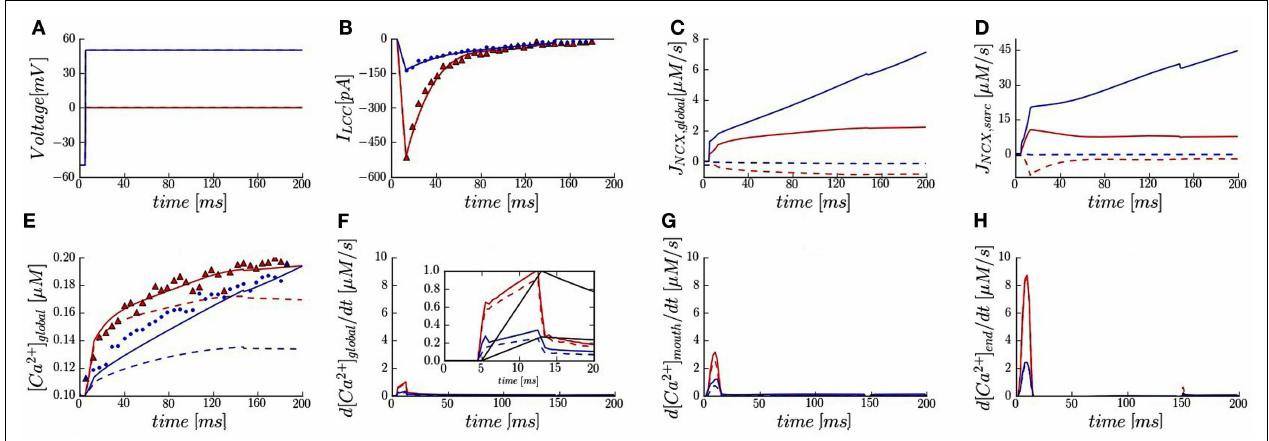
FIGURE 2 | Membrane currents, calcium signals, and trigger fluxes in the presence of 50 µ M Fluo-3. (A) Voltage-clamp protocols. (B) Whole-cell LCC current fitted and plotted ( solid lines ) vs. data reported in rabbits with SR blocked ( triangles and dots ). (C,D) Predicted global and sub-sarcolemmal Na + /Ca 2 + fluxes. (E) Global Ca 2 + transients ( solid and dash lines ) vs. experimentally measured ( triangles and dots ). (F) Predicted